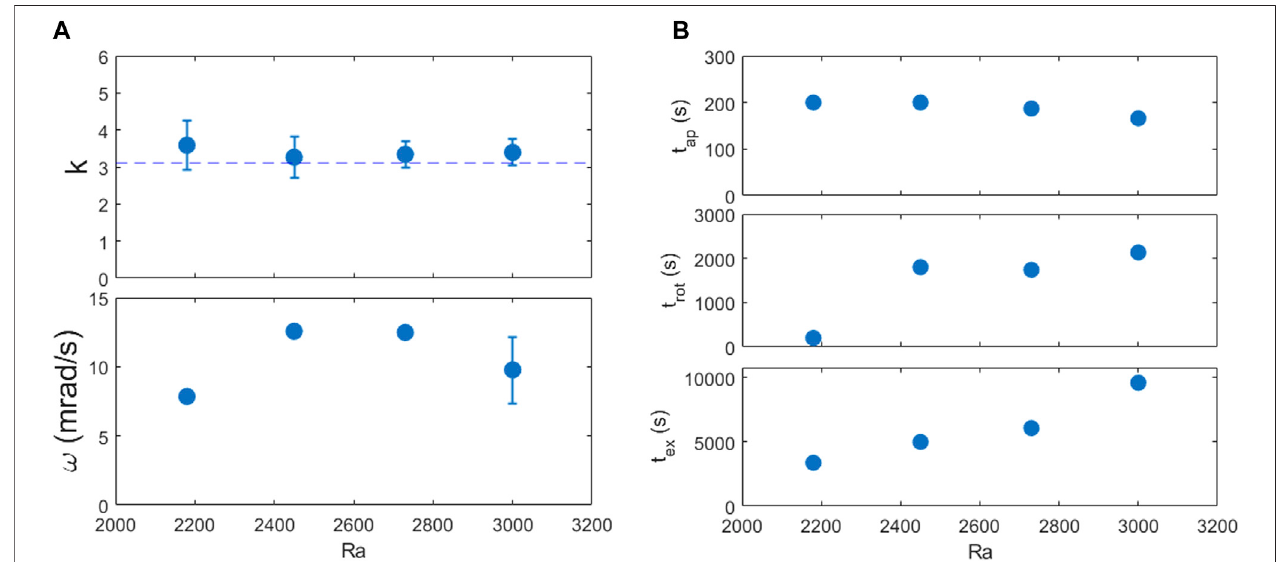
FIGURE 3 | (A) : dimensionless wave number k (top) and angular velocity ω of the patterns (bottom) as a function of Rayleigh number. The dashed line marks the theoretical wave number k c = 3.117 of Rayleigh-Bénard convection close to the onset. (B) : time needed for the appearance of the convective pattern, t ap (top), time for thebeginningoftherotationofthepattern, t rot (middle),andtimeofextinctionoftheconvectiveinstability, t ex (bottom),plottedasafunctionoftheRayleighnumber.Time t = 0 corresponds to the instant when the gradient gets